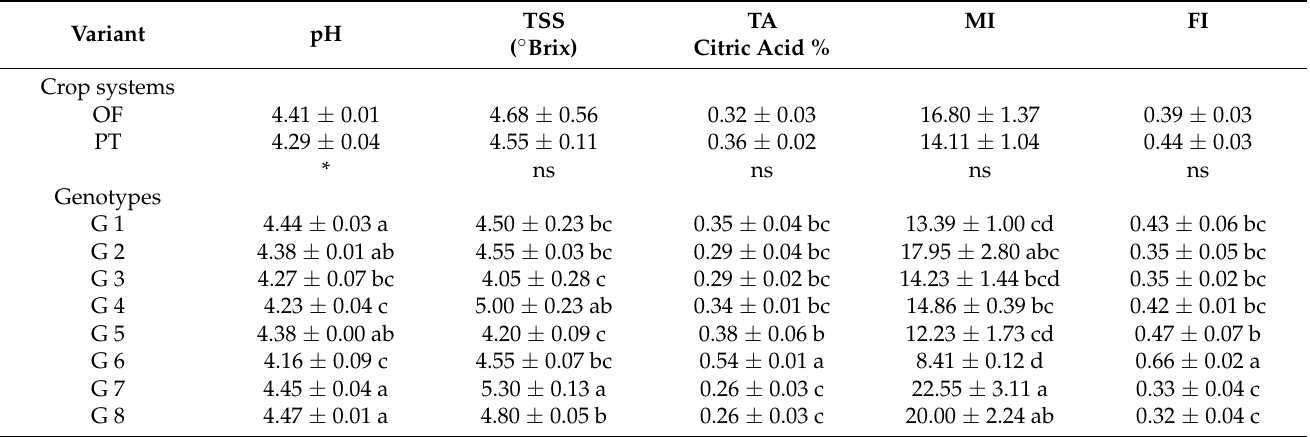
Table 2. The influence of the crop system and genotypes on physicochemical